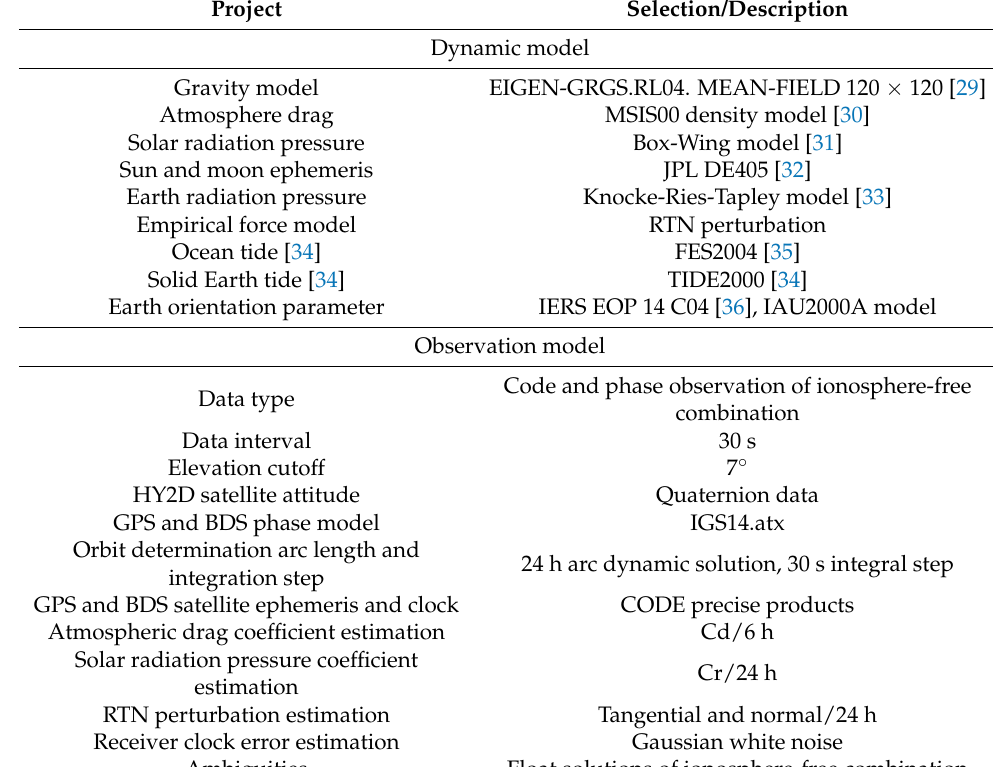
Table 4. Dynamical and observation model employed in the POD for